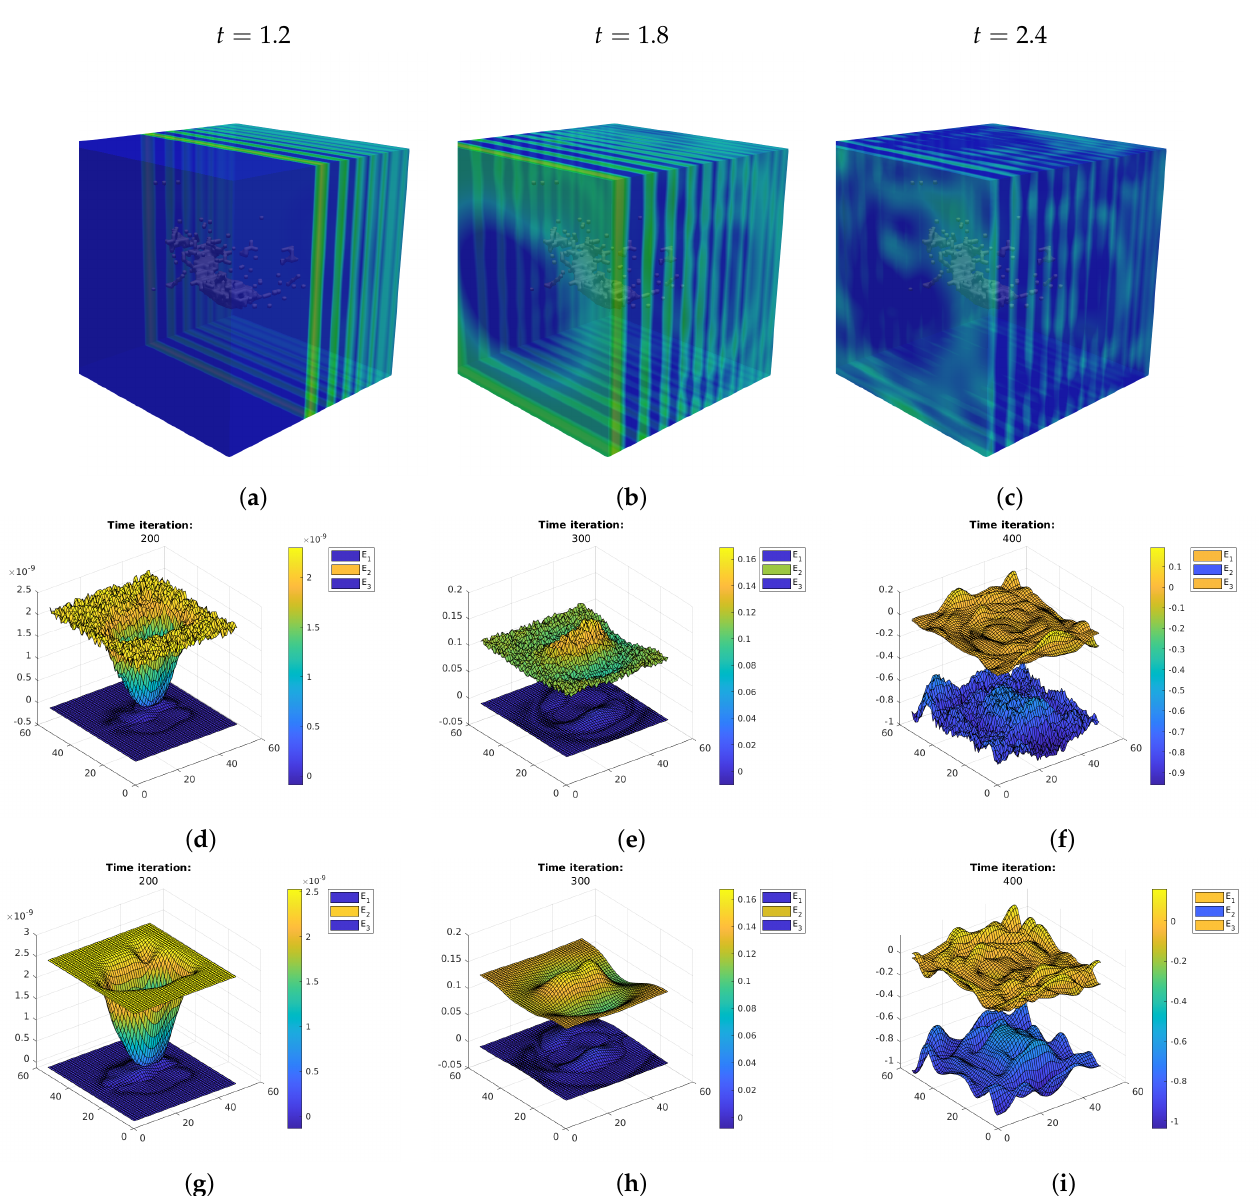
of model problem (45) at different times for ω = 40 in (46). ( d – f E h | |